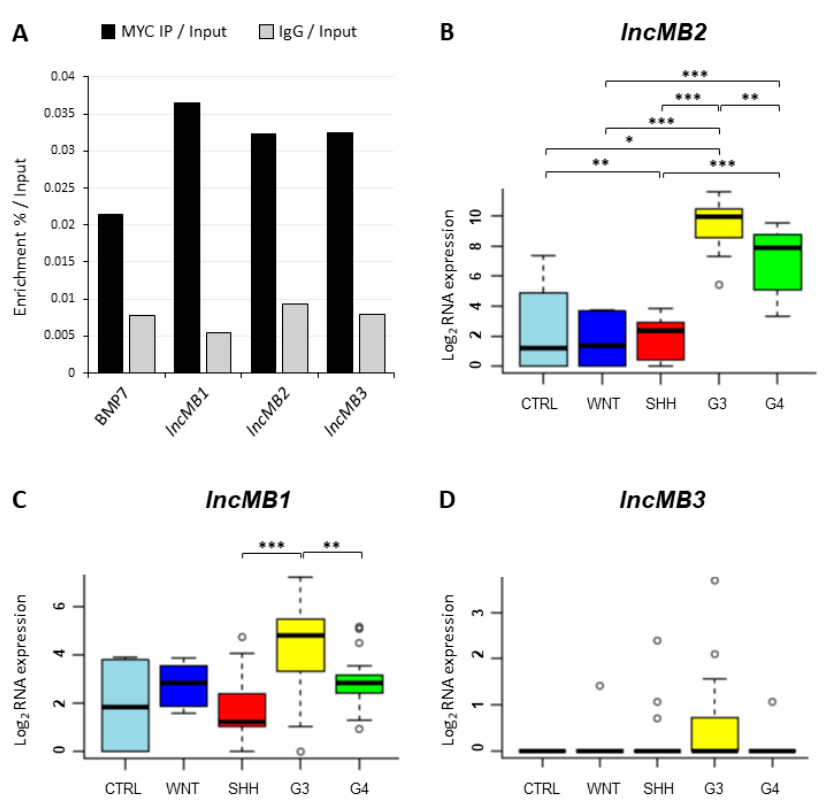
Figure 6. MYC-regulated lncMB1 , lncMB2 and lncMB3 expression in primary MB tumors. ( A ) MYC occupancy on regions upstream to lncMB1 , lncMB2 and lncMB3 transcriptional start site in DOX- untreated D283-OMO cells. BMP7 promoter region was used as positive control. IP and IgG enrichments are expressed as percentage relative to input. N = 1. ( B – D ) Expression levels of lncMB2 (panel B ), lncMB1 (panel C ) and lncMB3 (panel D ) in 4 control (CTRL) samples and 59 primary MBs, assessed from RNA-Seq data deposited by Luo et al., 2021 [28]. Results are expressed in log 2 (FPKM). * p ≤ 0.05, ** p ≤ 0.01, *** p ≤ 0.001 (two-tailed Student’s t